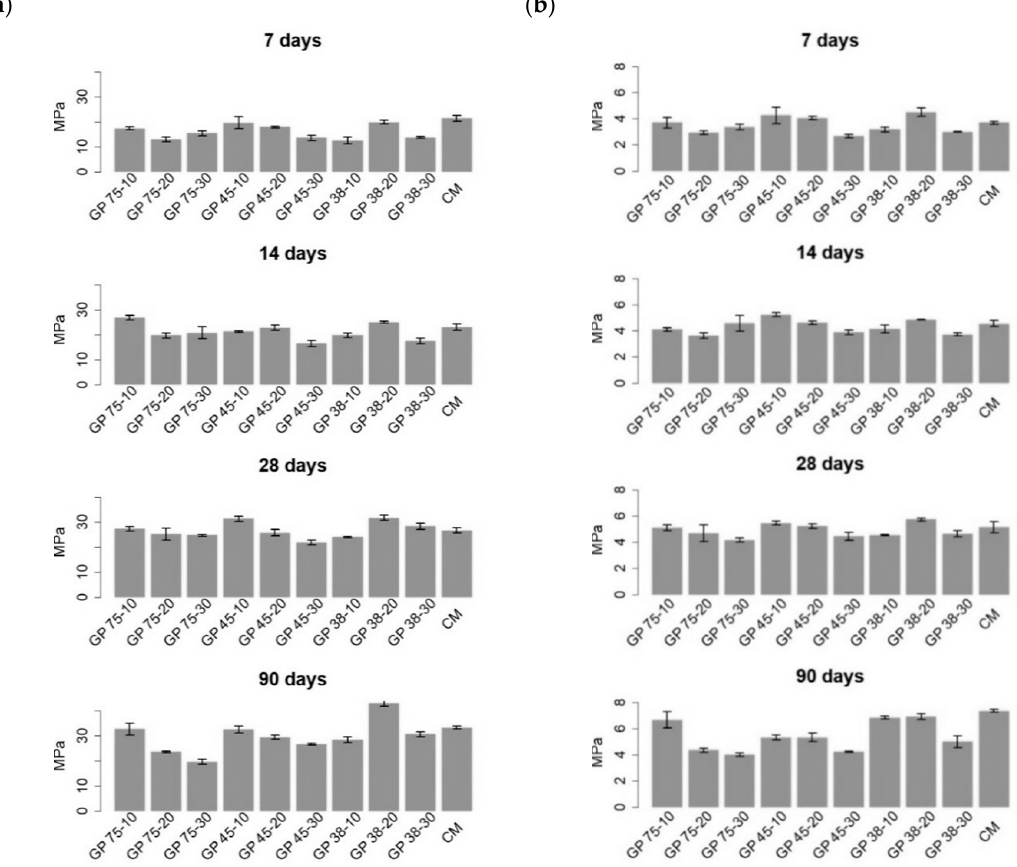
Figure 6. ( a ) Results of compressive strength. ( b ) Results of flexural strength.